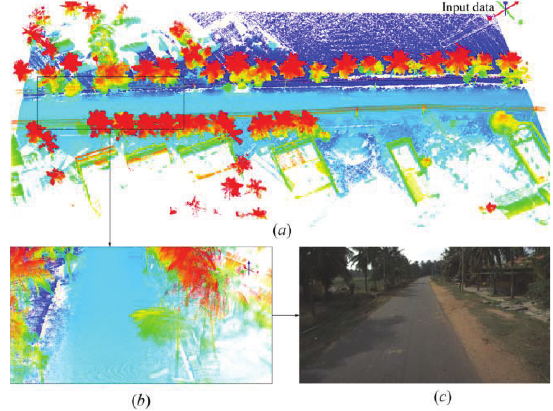
Figure 6. Perspective view of MLS data points: (a) along the roadway of 156 m of length (b) closure view showing the road coverage (c) photograph showing the characteristics of road surface at its boundary, that is, levelled surface.